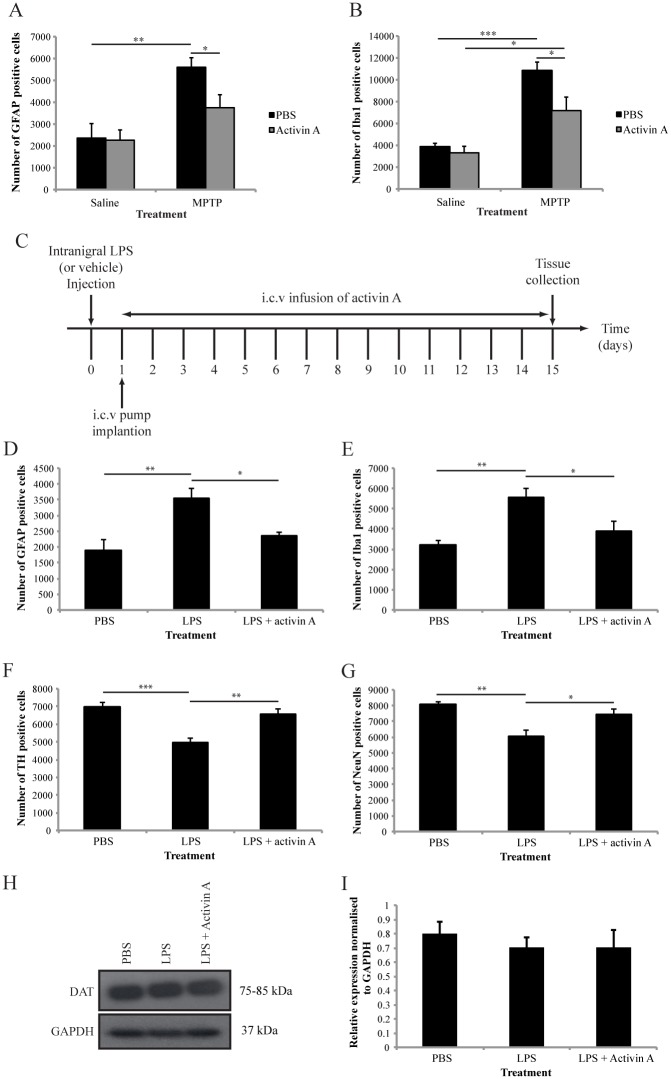
Activin A decreases MPTP and LPS-induced inflammation.Stereological quantification of the left SNpc demonstrated activin A significantly decreased the number of GFAP-immunoreactive cells (A) and Iba1-immunoreactive cells (B) in the SNpc following MPTP. (C) Timeline detailing LPS experimental procedures. Stereological quantification demonstrated activin A significantly reduces the LPS-induced increase in GFAP (D) and Iba1 (E) positive cells and subsequent loss of TH (F) and NeuN (G) positive cells. (H) Representative images of DAT and GAPDH expression. (I) Western blot analysis of striatal protein extracts revealed LPS does not alter DAT expression. All values represent the mean ± SEM. *p<0.05, **p<0.01, ***p<0.001. N = 3-5/group.